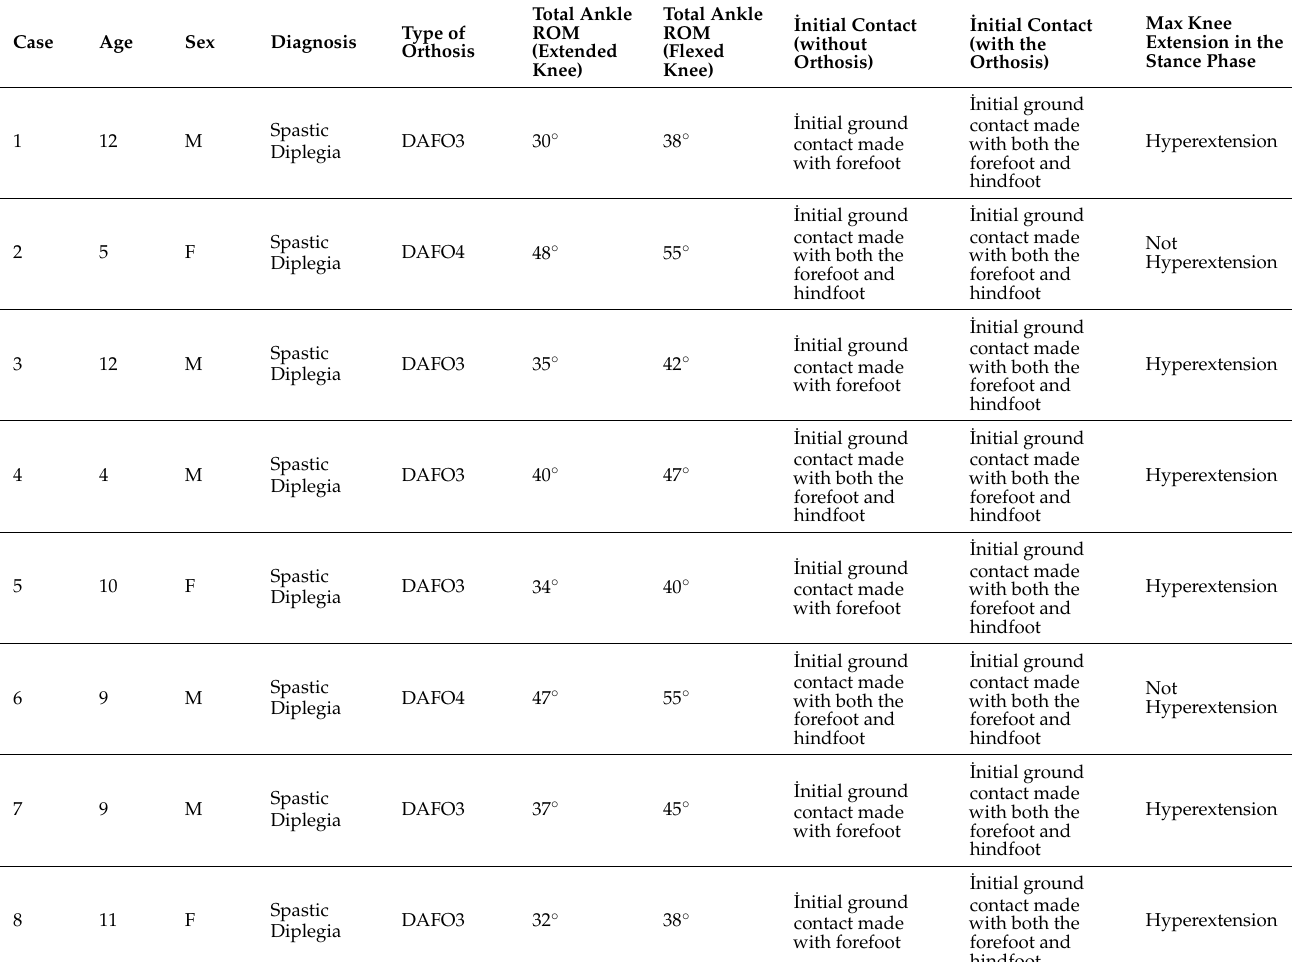
Table 1. Patient information. M, male; F, female; ROM, range of motion; ( ◦ )